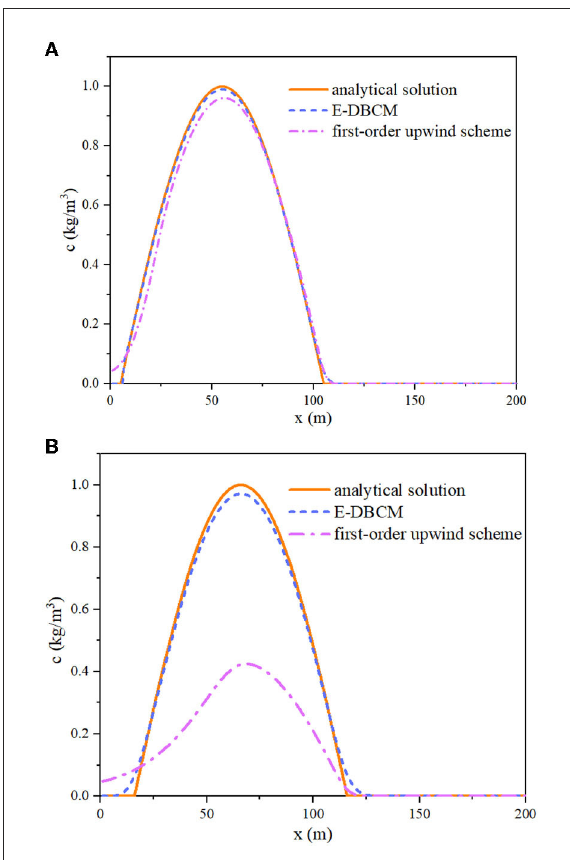
FIGURE3 Comparison of the numerical accuracy of different schemes: (A) t = 50 s ; (B) t = 100 s .